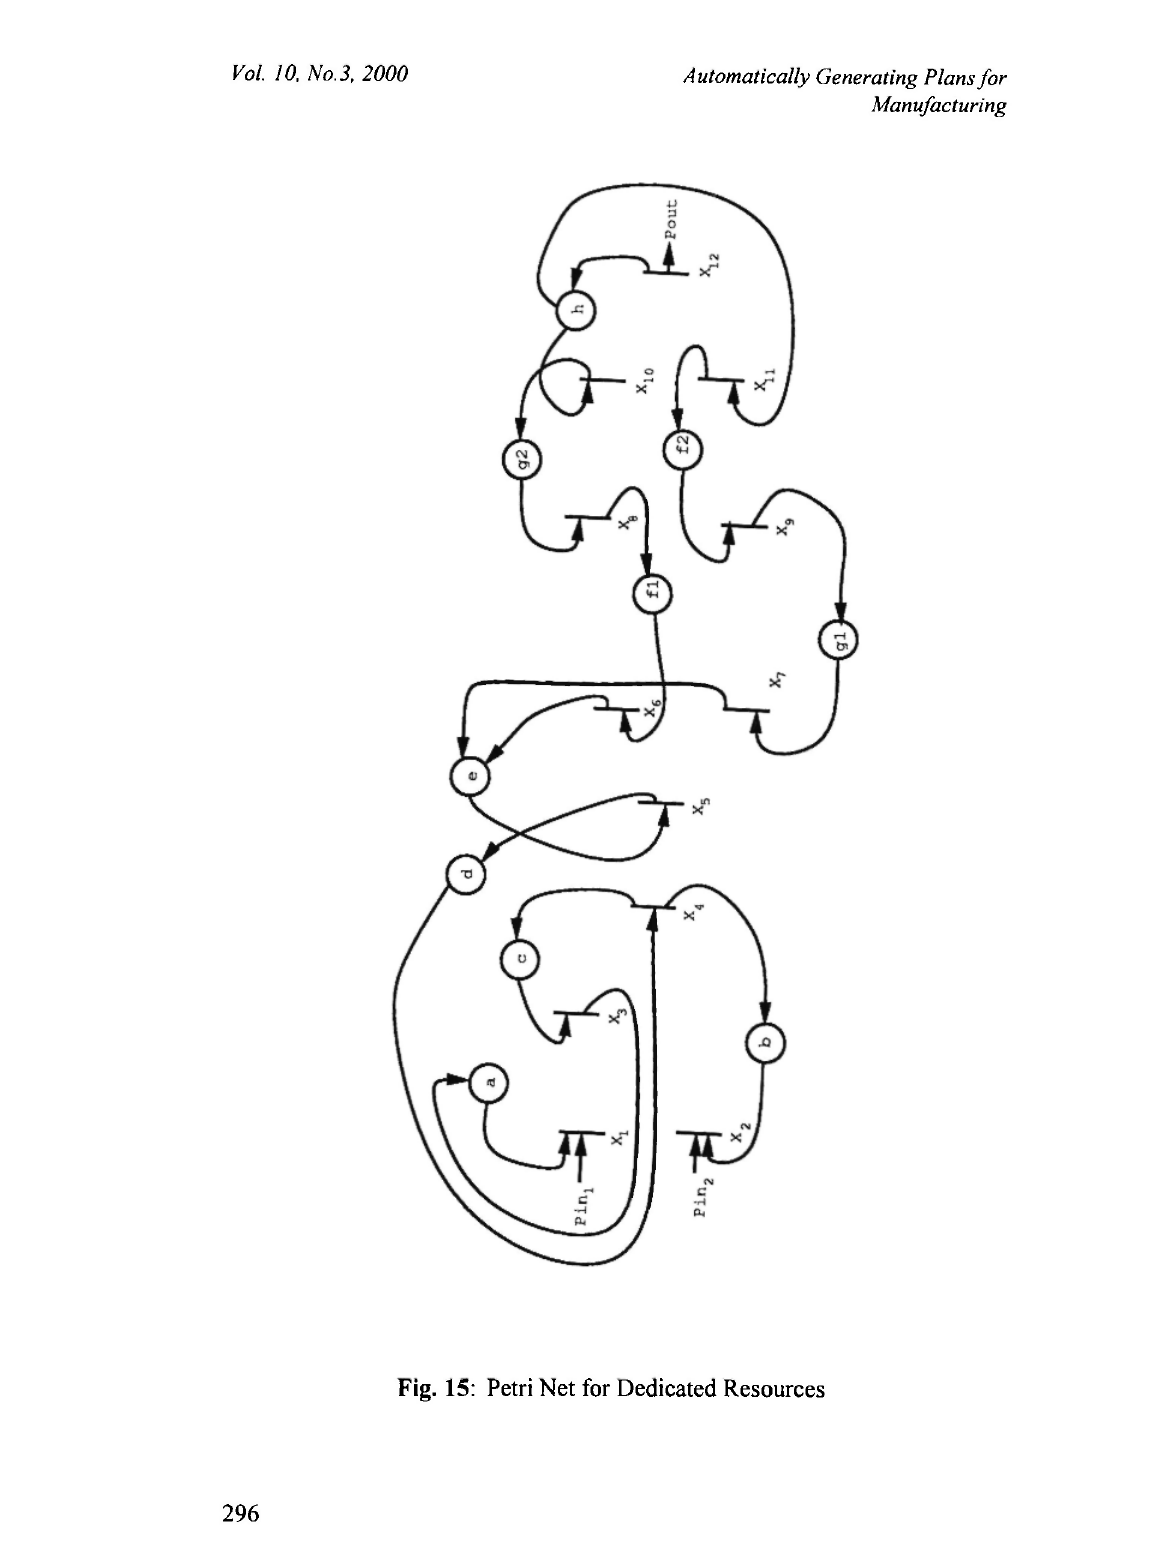
Fig. 15: Petri Net for Dedicated